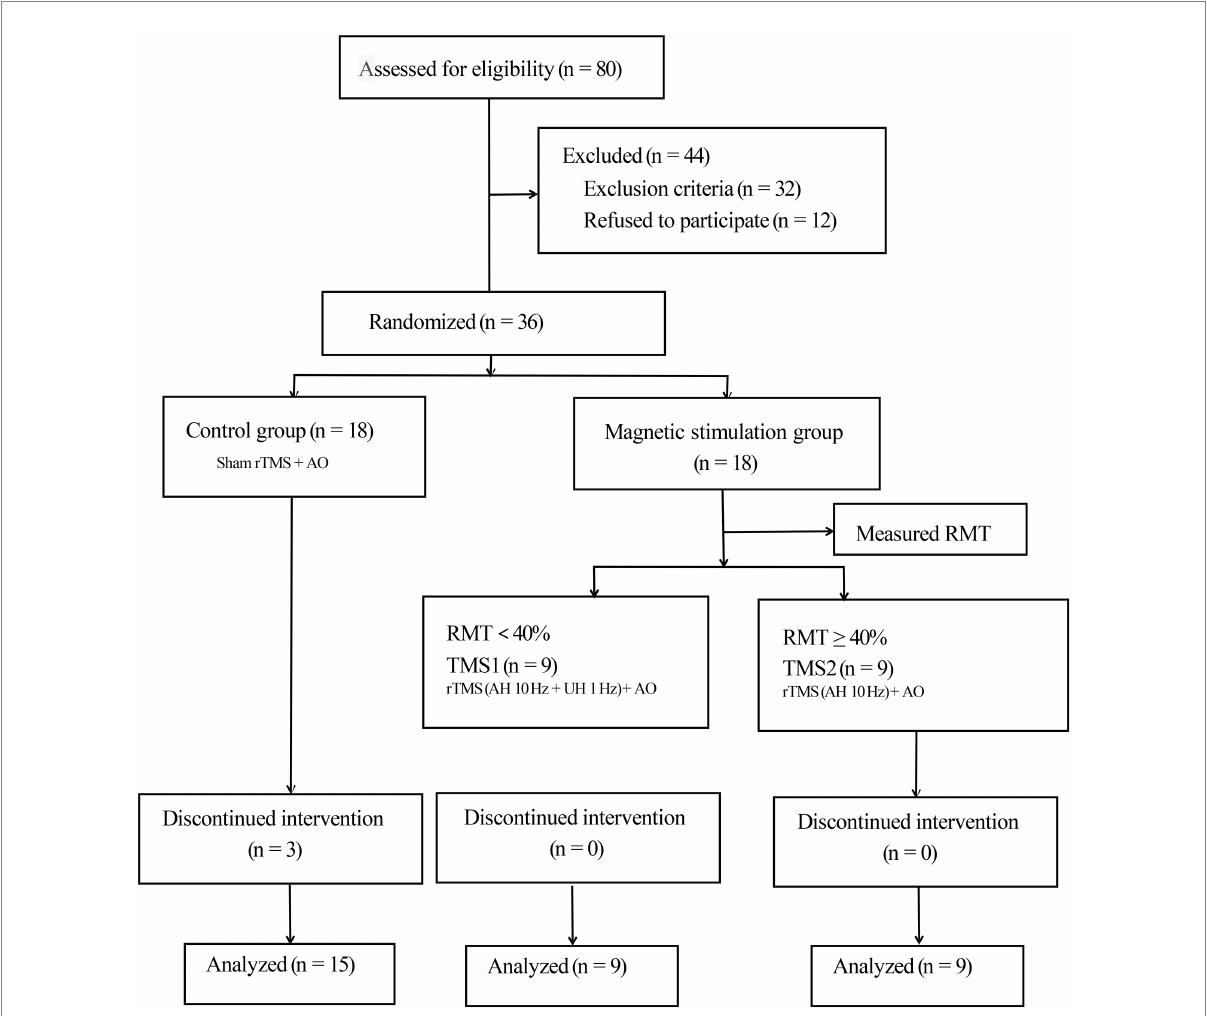
FIGURE 1 Consolidated Standards of Reporting Trials flow diagram. rTMS, repetitive transcranial magnetic stimulation; AO, action observation; AH, affected hemisphere; UH, unaffected hemisphere; RMT, resting motor